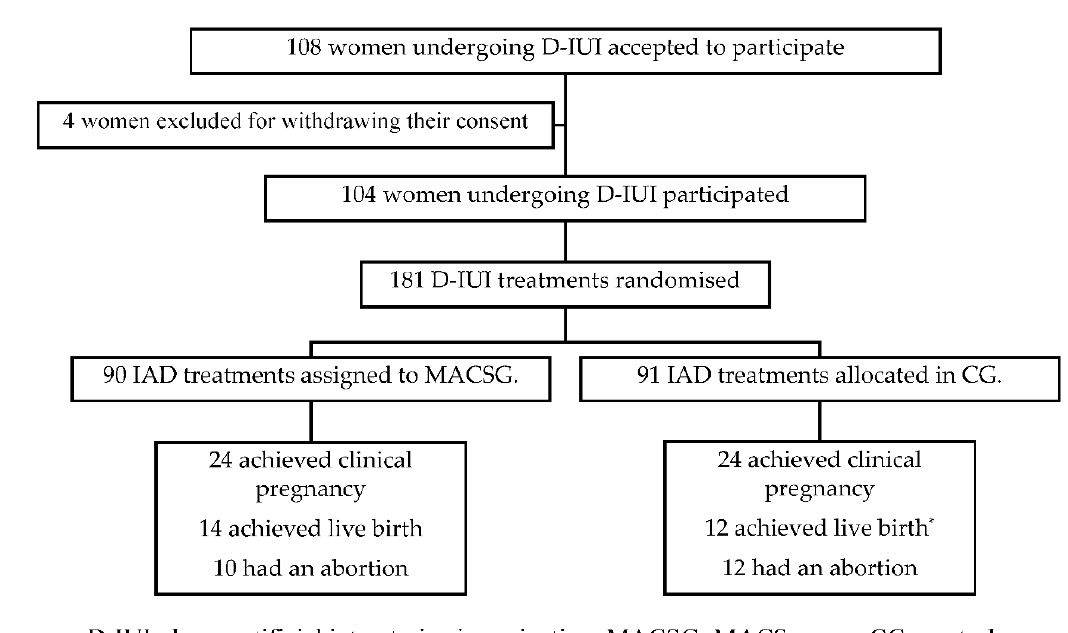
Figure 1. Flowchart of eligible treatments and allocation: MACSG versus CG group. Table 1. Seminal parameters. Characteristics of the seminal samples and sperm functions obtained after ejaculation and before insemination in MACSG and CG. Basal